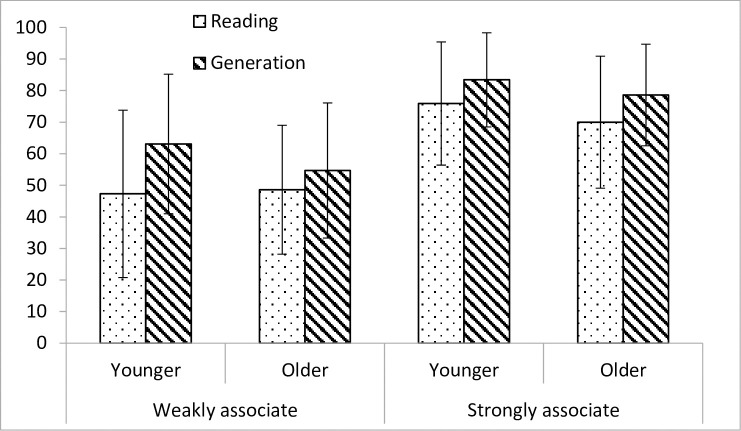
Mean percentages of correct answers obtained for younger and older participants as a function of strategy (reading and generation) and association (weakly associate and strongly associate).